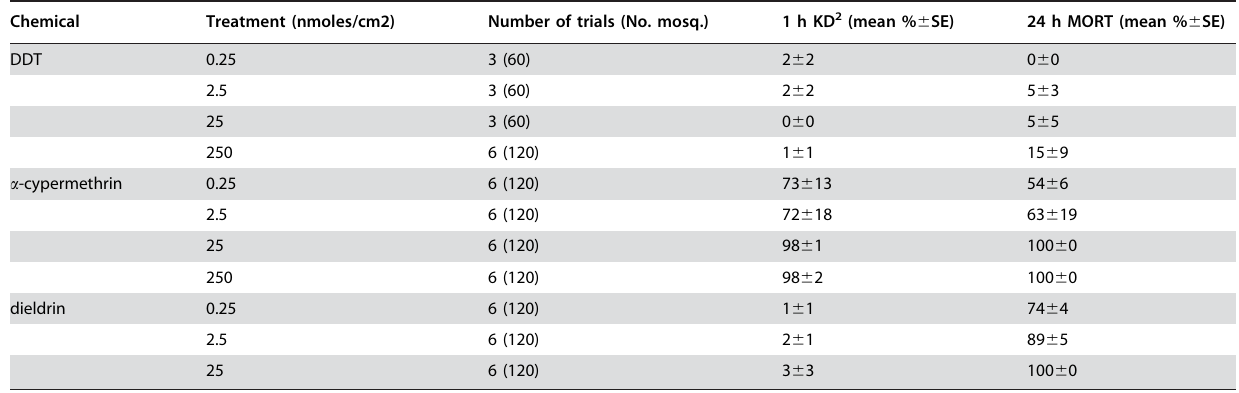
Chemical Treatment (nmoles/cm2) Number of trials (No.